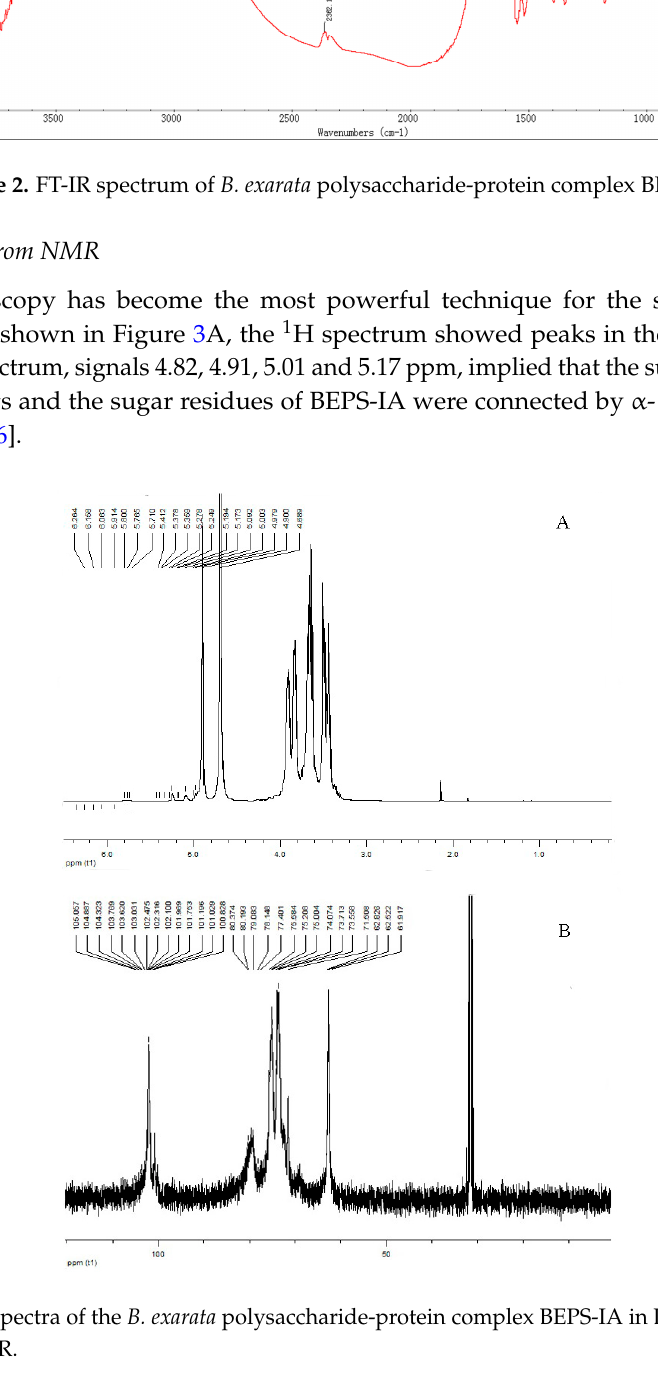
Figure 3. NMR spectra of the B. exarata polysaccharide-protein complex BEPS-IA in D 2 O. ( A ) 1 H-NMR and ( B ) 13 C-NMR.